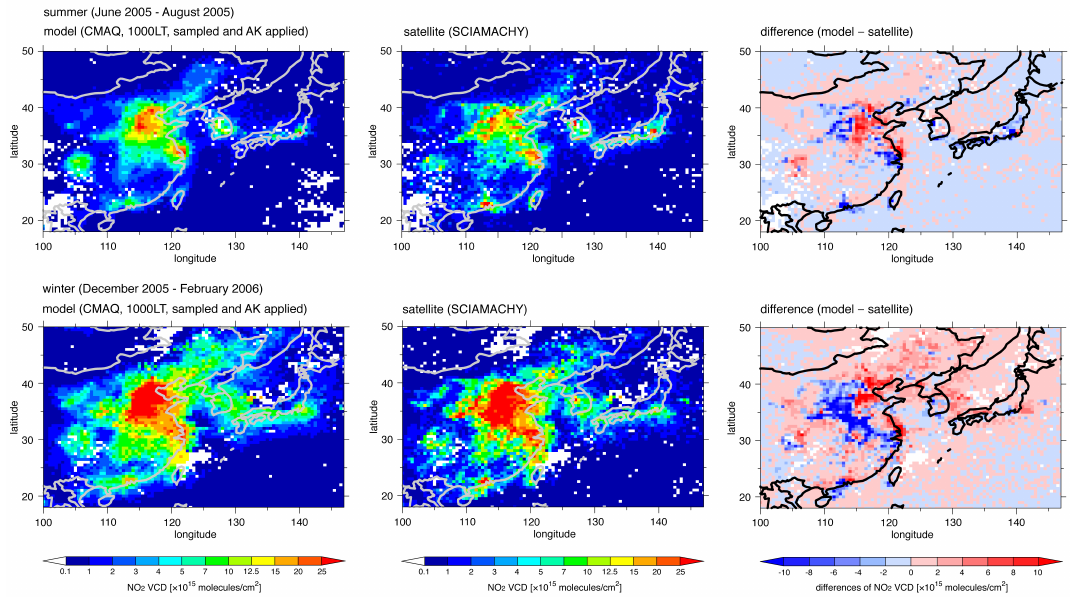
Fig. 4. Same as Fig. 3, but model results are sampled with valid pixels and the averaging kernel (AK) information of SCIAMACHY data